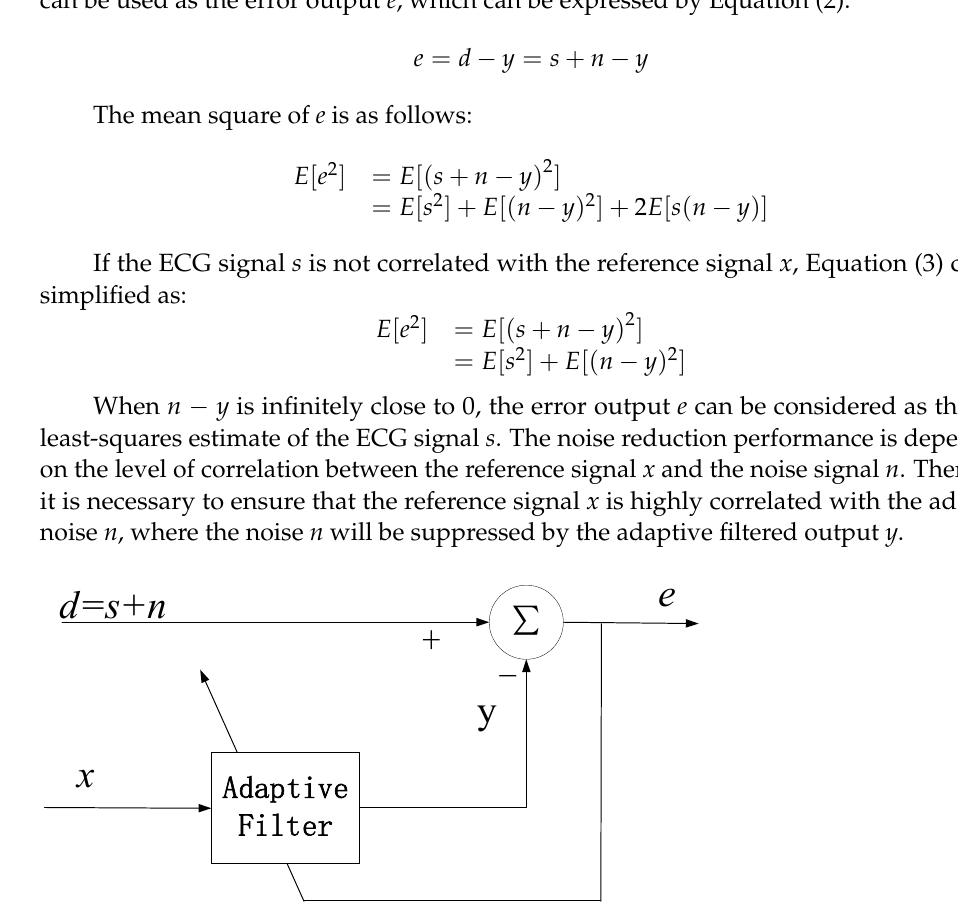
Figure 1. The adaptive noise canceling concept.